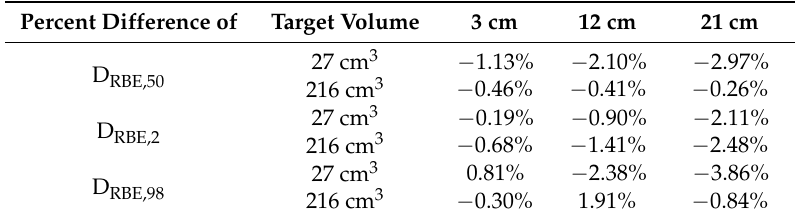
Table 3. Percent D RBE difference comparison for Microdosimetric Kinetic Model (MKM) D RBE VH between FRoG and MC for 12 C